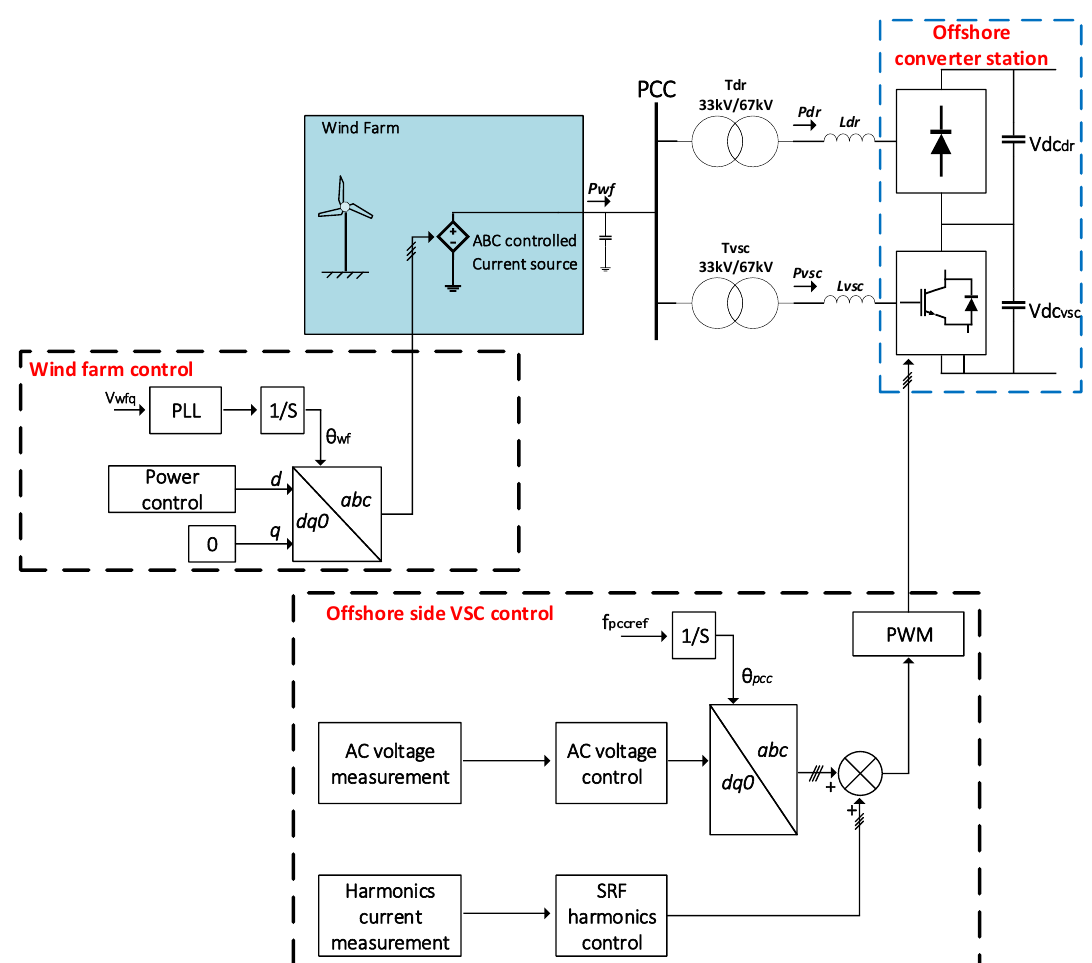
Figure 3. Control block diagram of the offshore VSC (OF-VSC) and wind farm (WF).